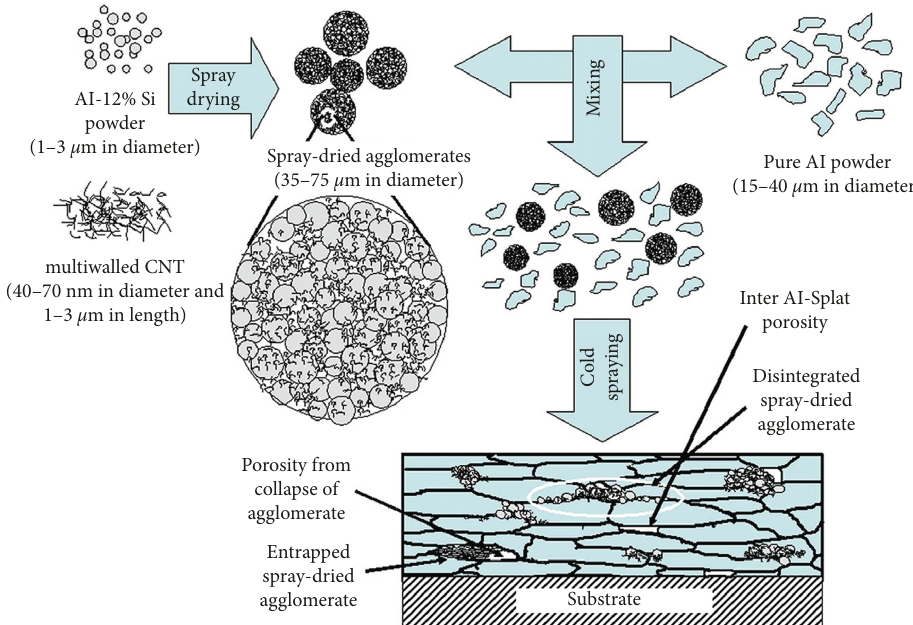
Figure 11: Schematic of the coating fabrication procedure using spray drying MMC powders [44].